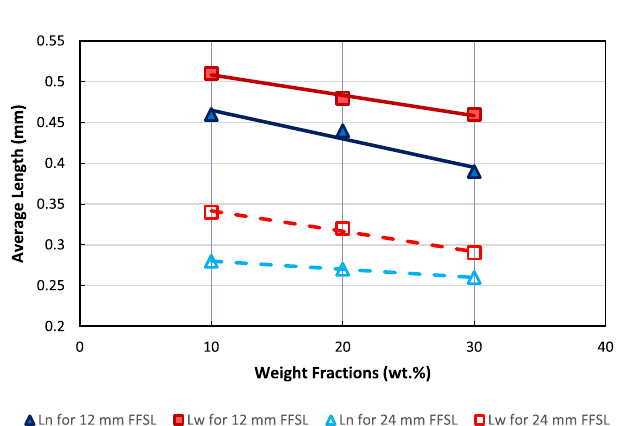
Figure 4. Weighted ( L w ) and number ( L n ) average lengths after burn-out of composites with different fiber feedstock lengths